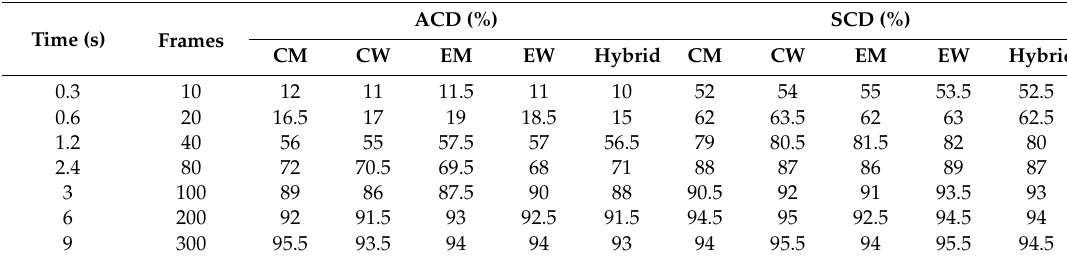
Table 5. Average detection rates for ACD and SCD (%).